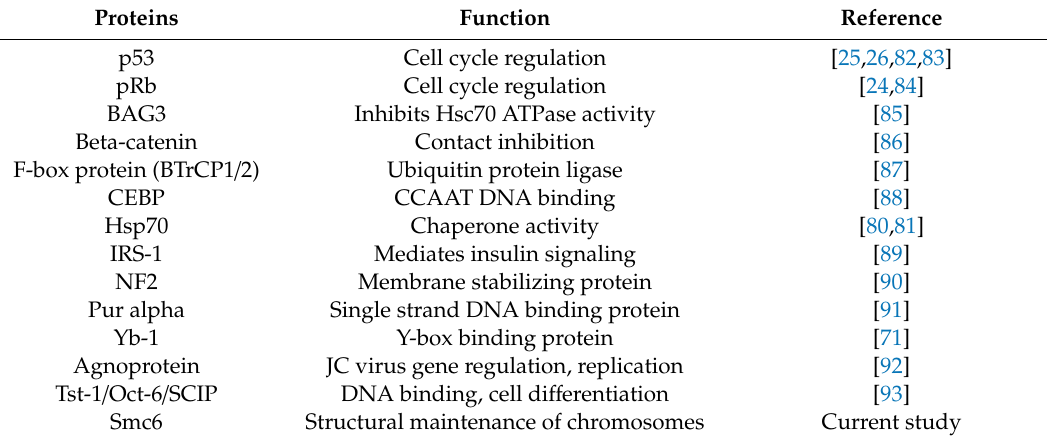
Table 2. Currently and previously reported host proteins that interact with JCV